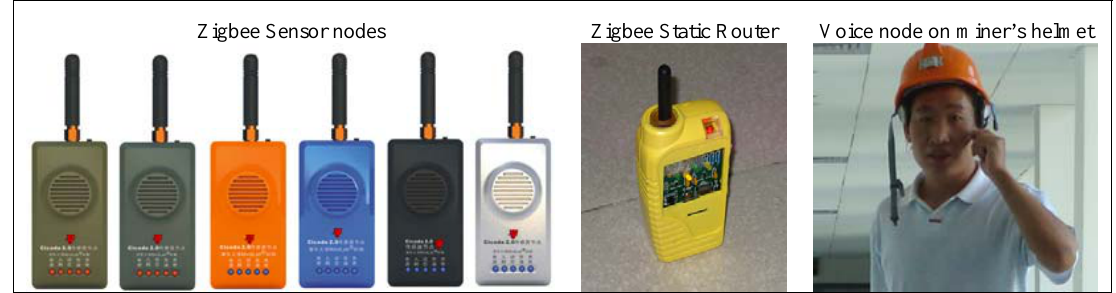
Figure 6. Pictures of Cicada physical